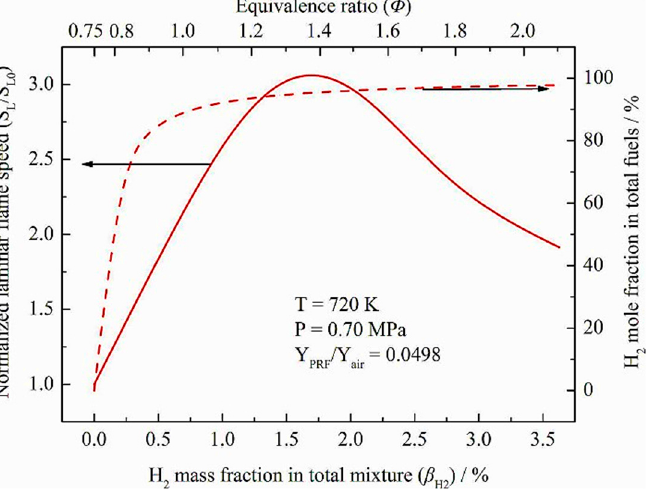
Figure 5. Flame speed at various hydrogen mass fractions in relation to equivalence ratios (Yang et al. [67]).